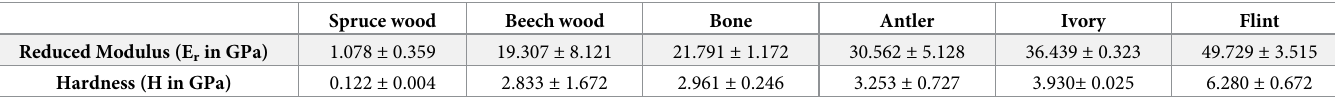
Table 2. Raw materials average hardness and Er values. These values are calculated by taking all the measurements into account for each sample. Materials are listed in increasing order of hardness, from the softest (Spruce) to the hardest (Flint). Spruce